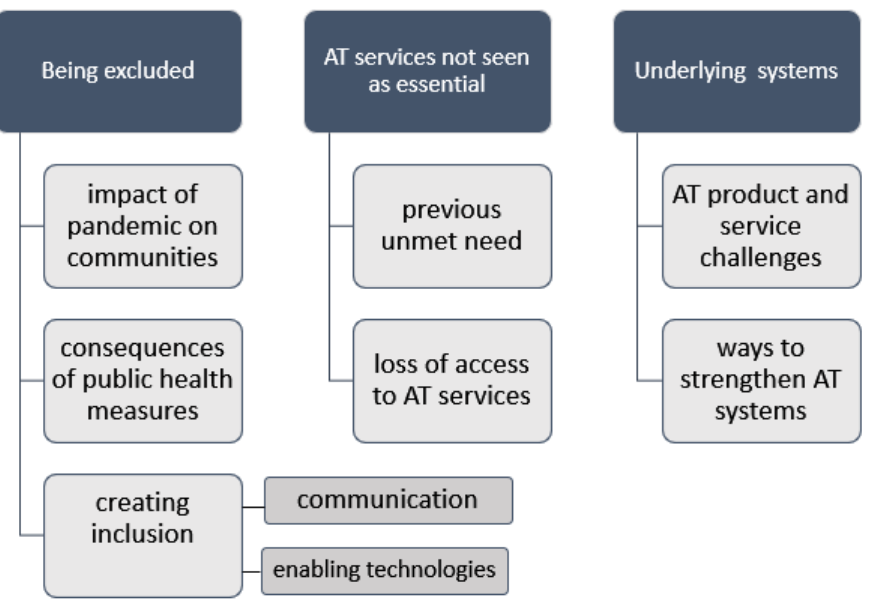
Figure 5. Thematic tree of experiences of AT users during the COVID-19 pandemic.